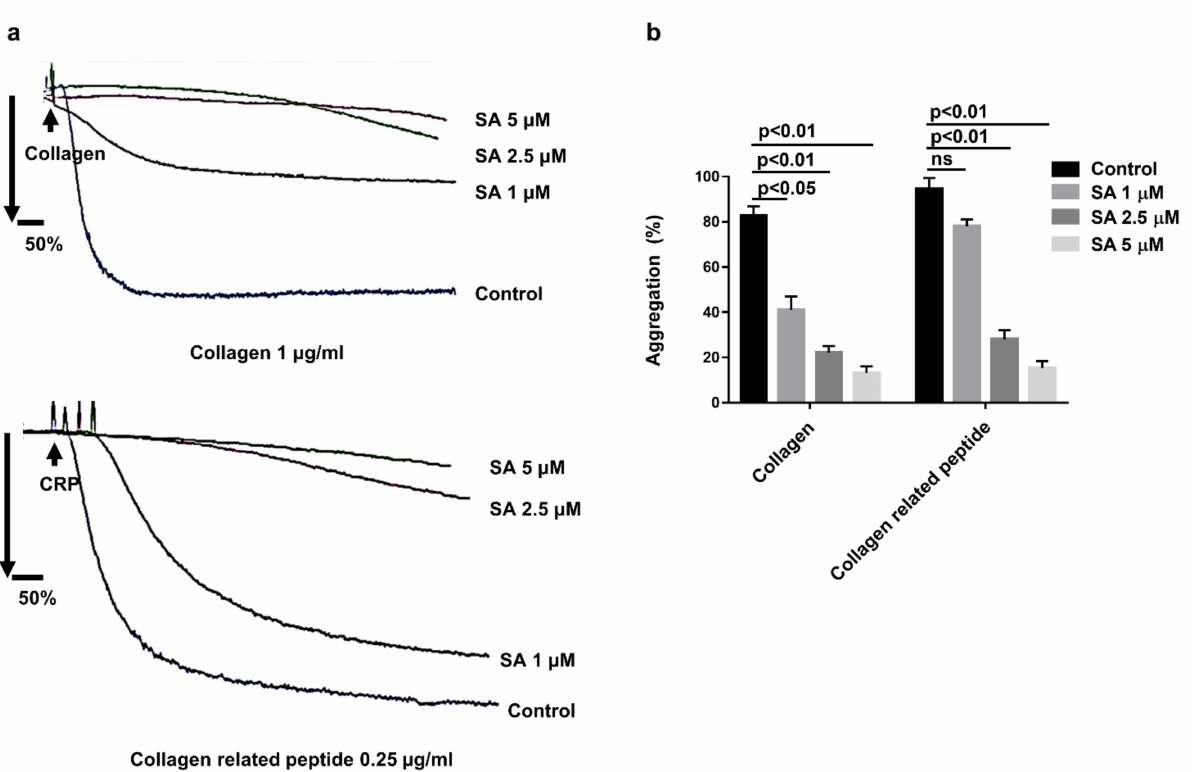
Figure 3. Effects of sanguinarine on collagen and collagen-related peptide-induced human platelet aggregation of washed human platelets. ( a ) Washed human platelets (3 × 10 8 /mL) were preincubated for 10 min with different concentrations of sanguinarine (1, 2.5, 5 µ M) or DMSO (control), followed by stimulation with different agonists. ( b ) Data were shown as mean ± SEM ( n = 5) and examined using one-way ANOVA